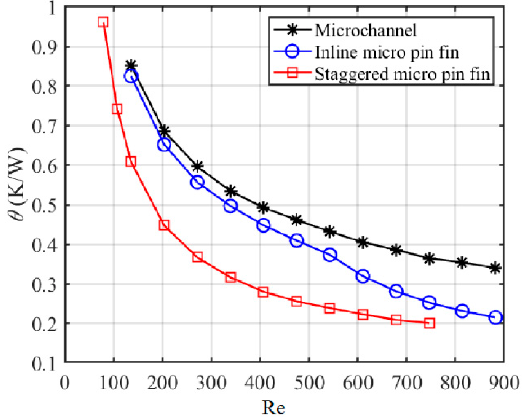
Figure 7. Variations of the average thermal resistance with the Reynolds number.